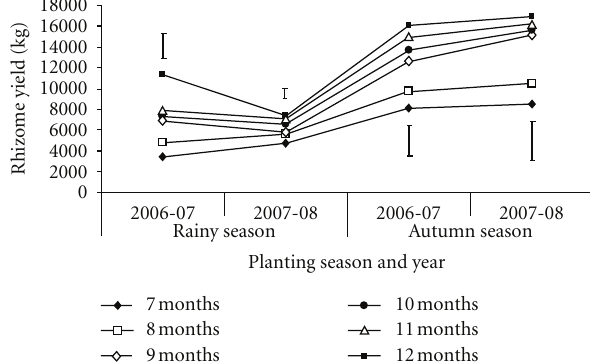
Figure 1: Rhizome yield of Acorus calamus (sweet flag) harvested at di ff erent durations over two seasons and two years. Bars indicate CD 0 . 05 within the same treatment and